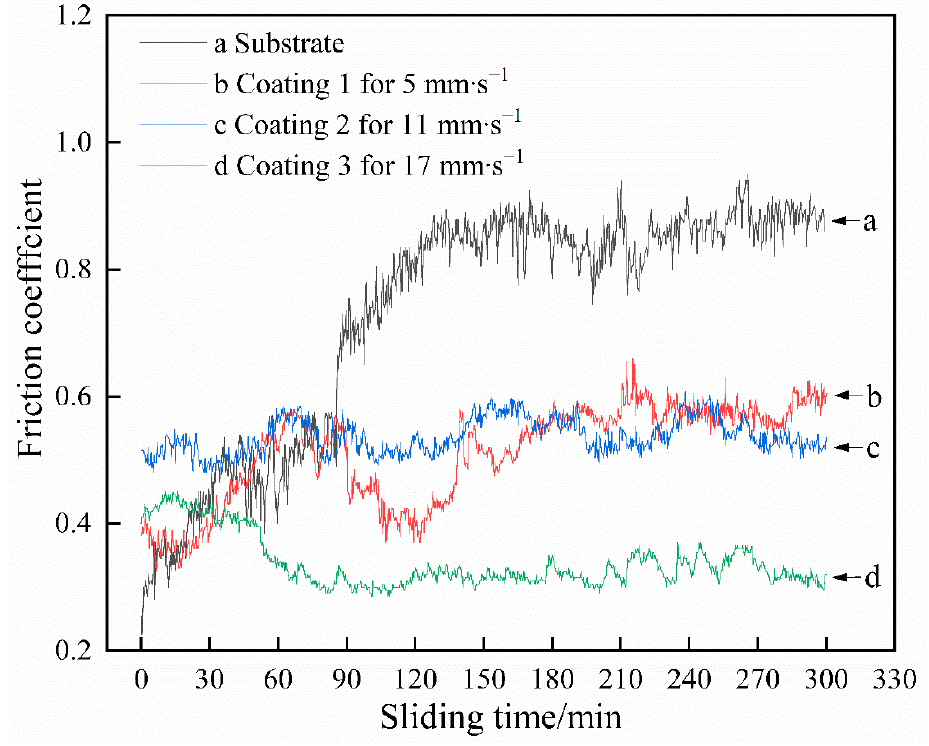
Figure 8. Variation of friction coefficient of the samples with sliding time in the 3.5 wt.% NaCl solution.